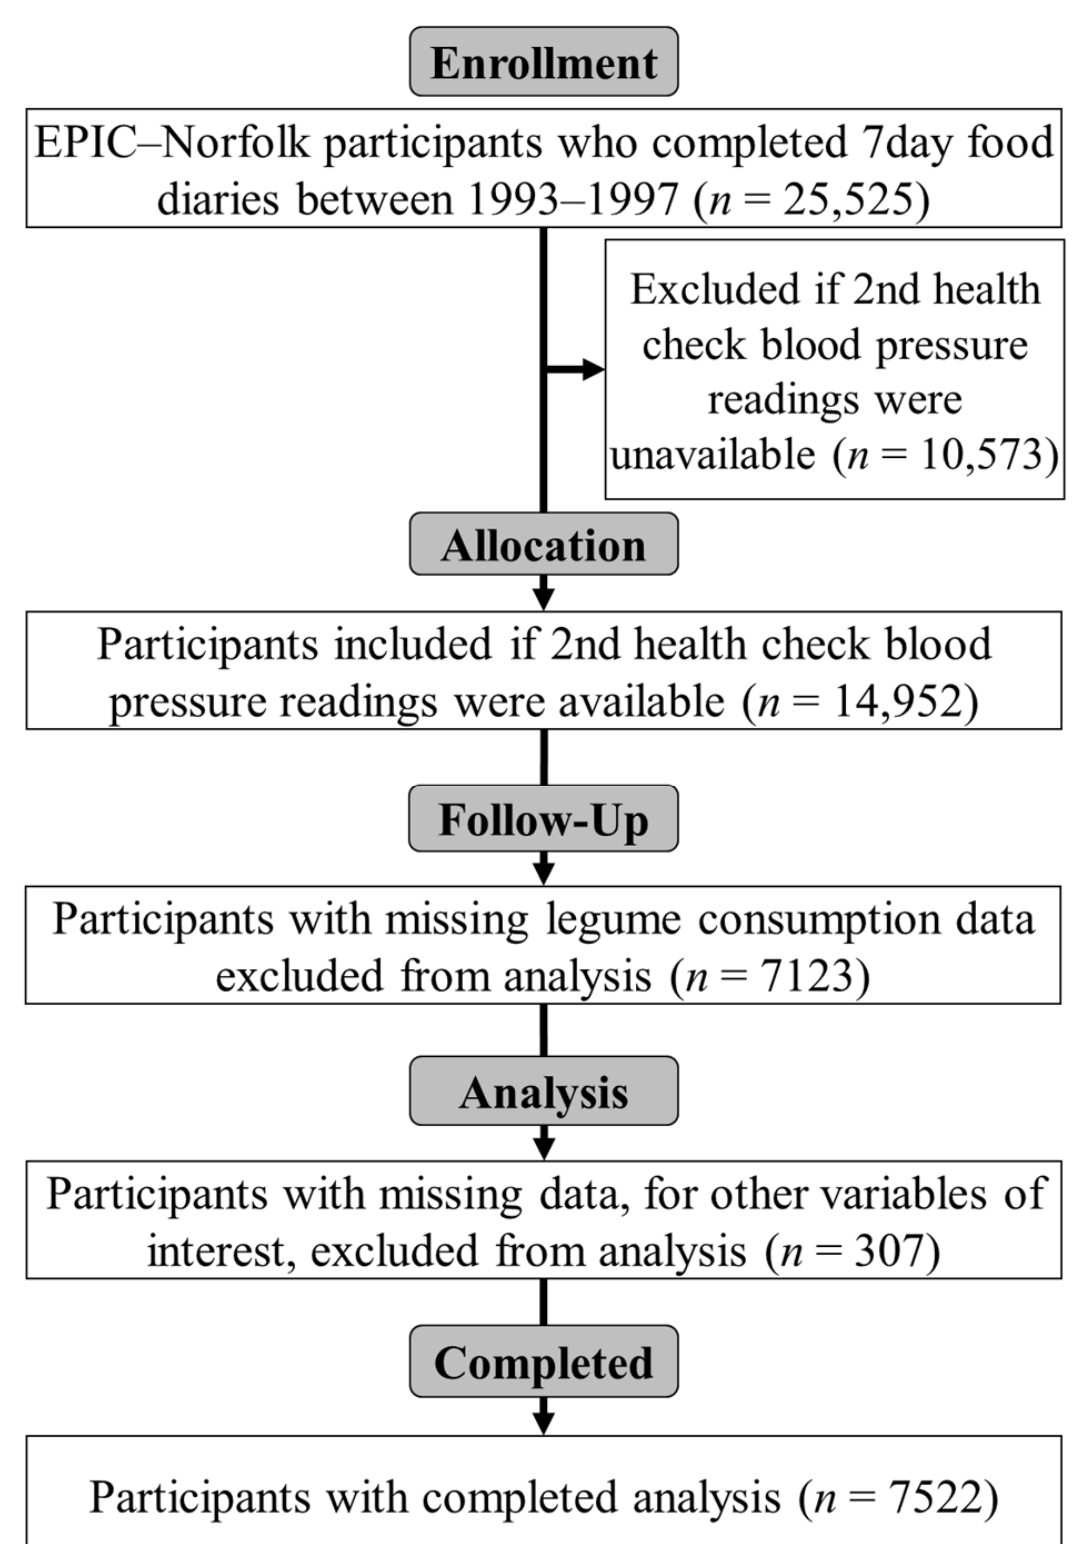
Figure 1. Consolidated Standards of Reporting Trials (CONSORT) diagram summarizing participant flow with the sizes ( n ) of initial and analysed groups.